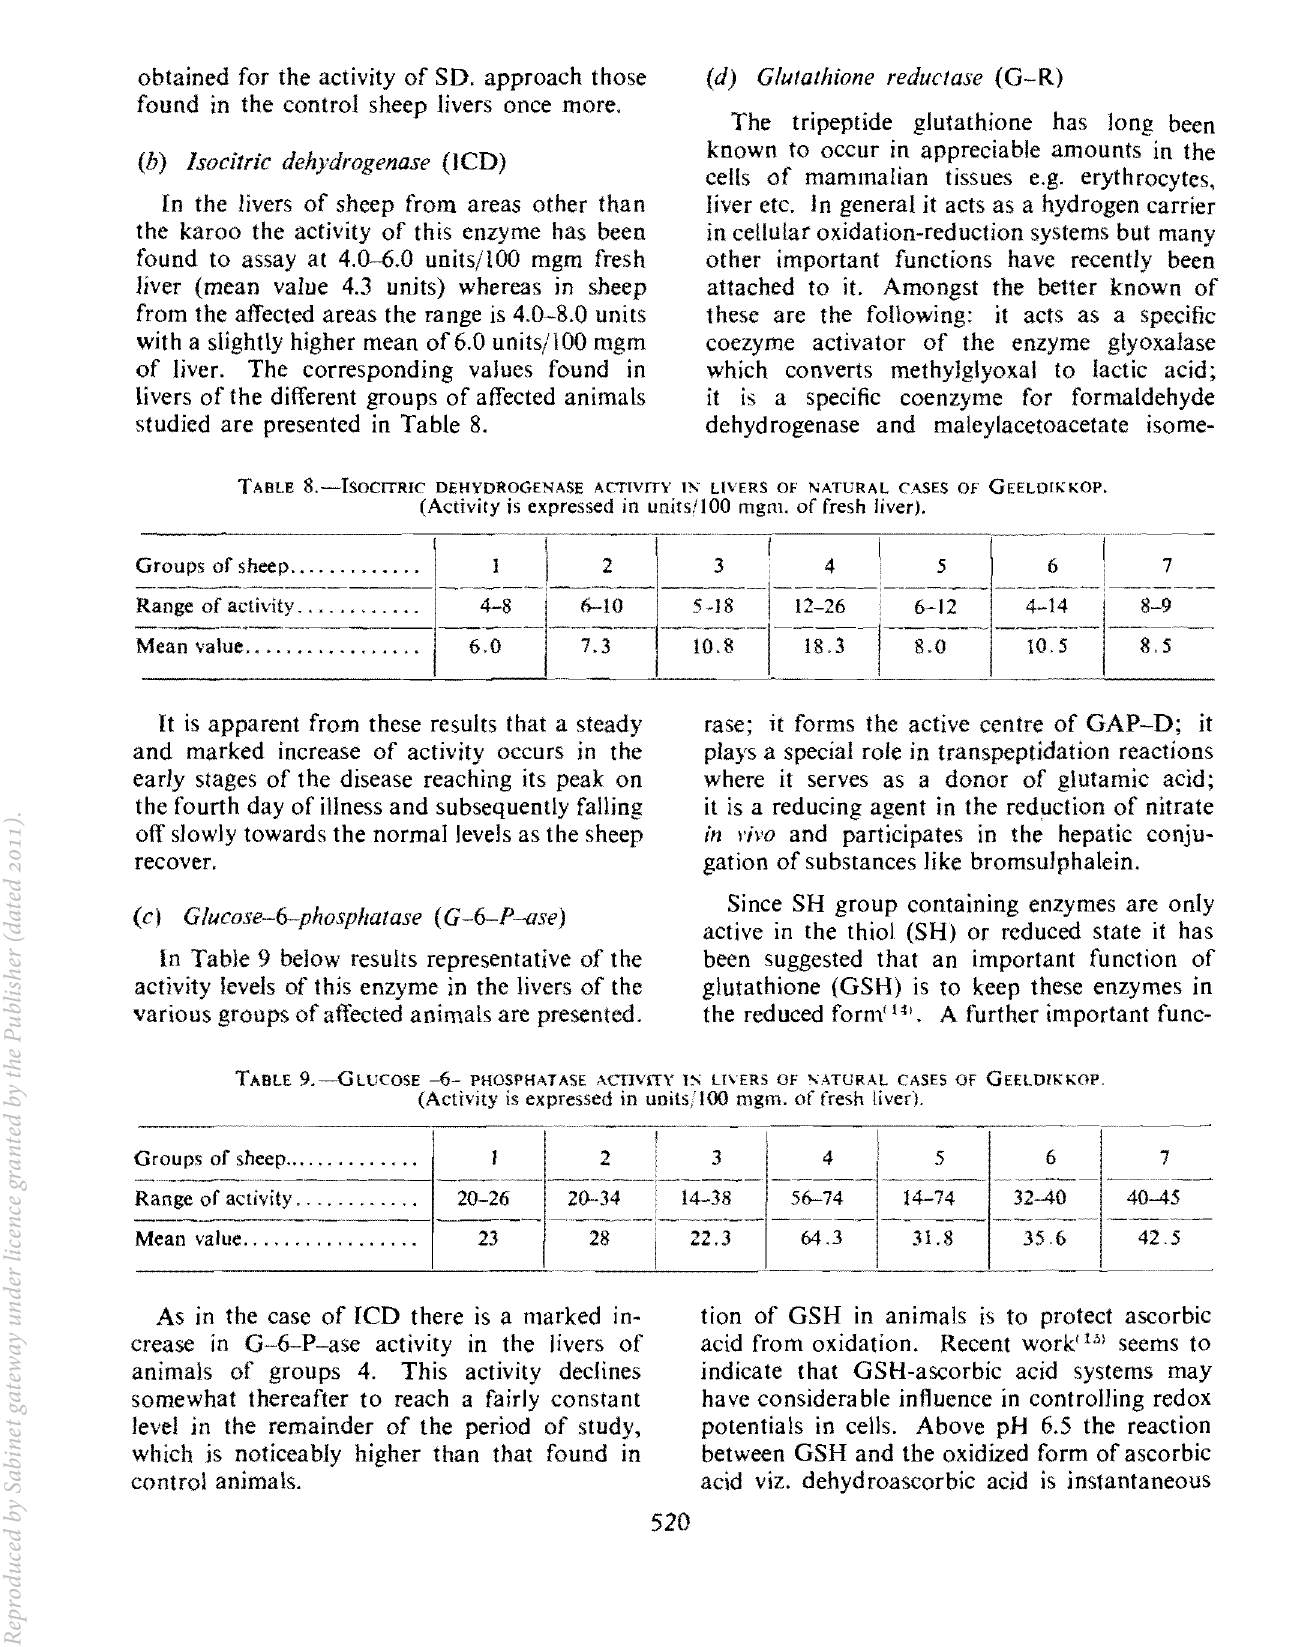
TABLE 9.-GLUCOSE -6- PHOSPHATASE ACTIVITY IS UVERS OF "ATURAL CASES OF GEELDIKKOP. (Activity is expressed in units/tOO mgm. of fresh